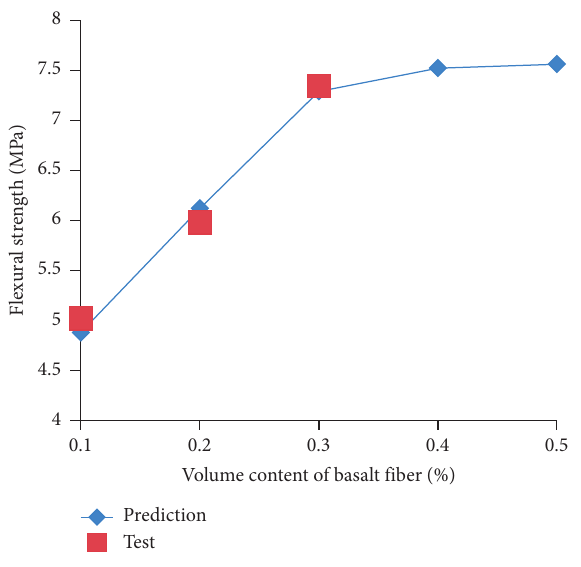
Figure 11: Variation of flexural strength of